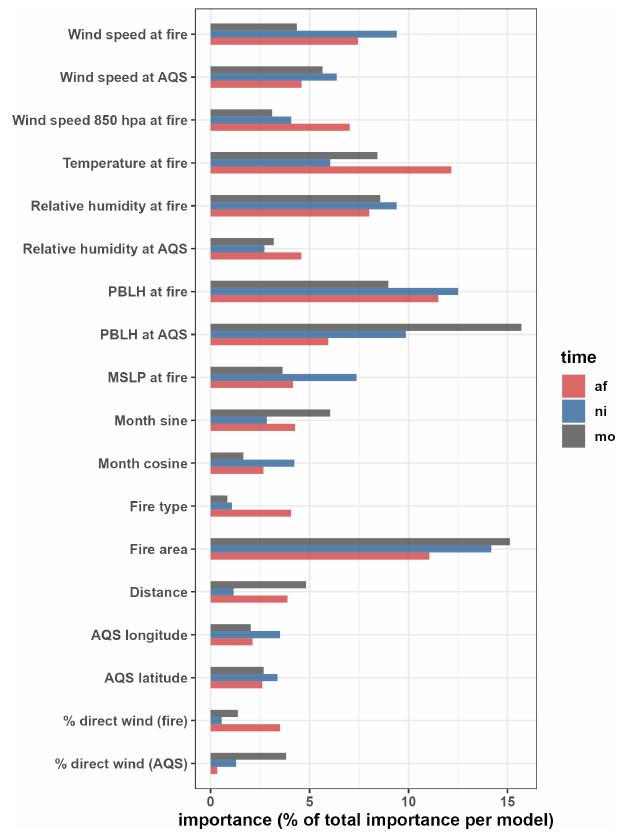
Figure 5. Variable importance for each model. A common x scale was assigned, which is the percentage of the total permutation im- portance attributable to each variable (i.e. importance / sum (impor- tance) × 100).